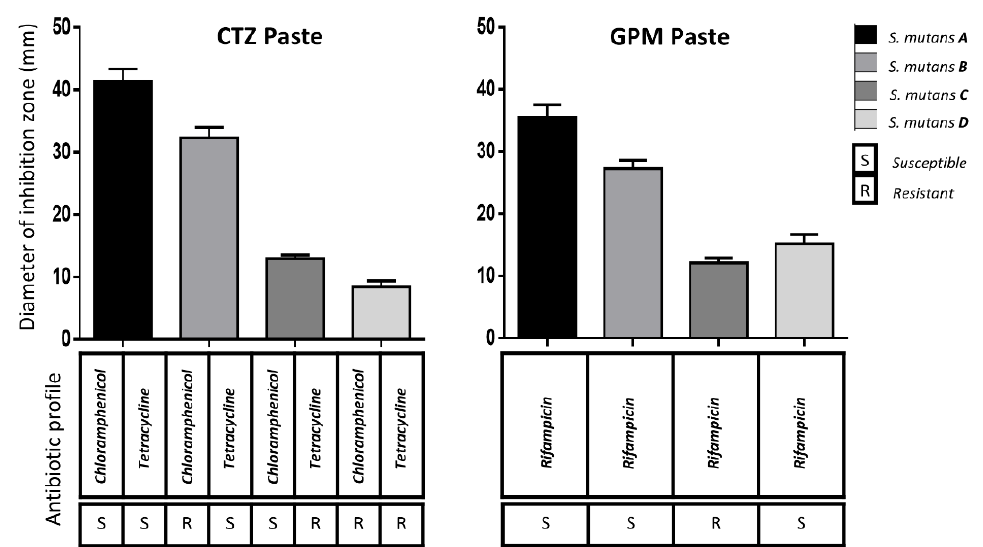
Figure 1. Average and standard deviation of the inhibition zones on the four different S. mutans strains with the use of CTZ and GPM pastes. Under the bars, the specific antibiotic profile of each strain is shown. All the comparisons showed differences ( p < 0.05). Two-way ANOVA and post hoc Tukey–Kramer multiple comparisons test were applied.